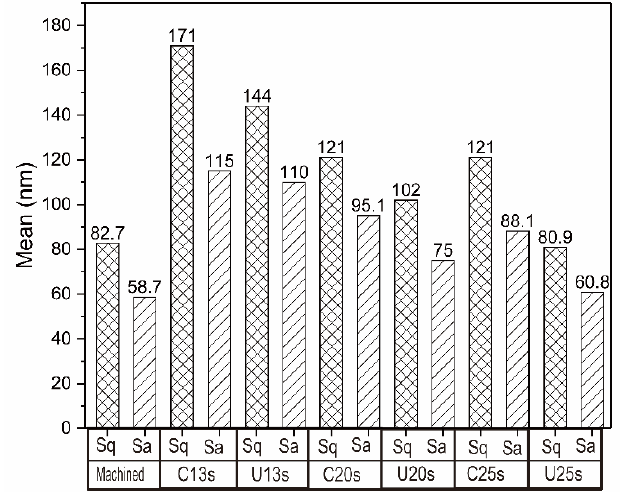
Figure 5. Root mean squared roughness (Sq) and arithmetic average roughness (Sa) on titanium (Machined) after IHT for 13 s (C13s), 20 s (C20s) and 25 s (C25s), ultrasonic-assisted IHT for 13 s (U13s), 20 s (U20s) and 25 s (U25s).